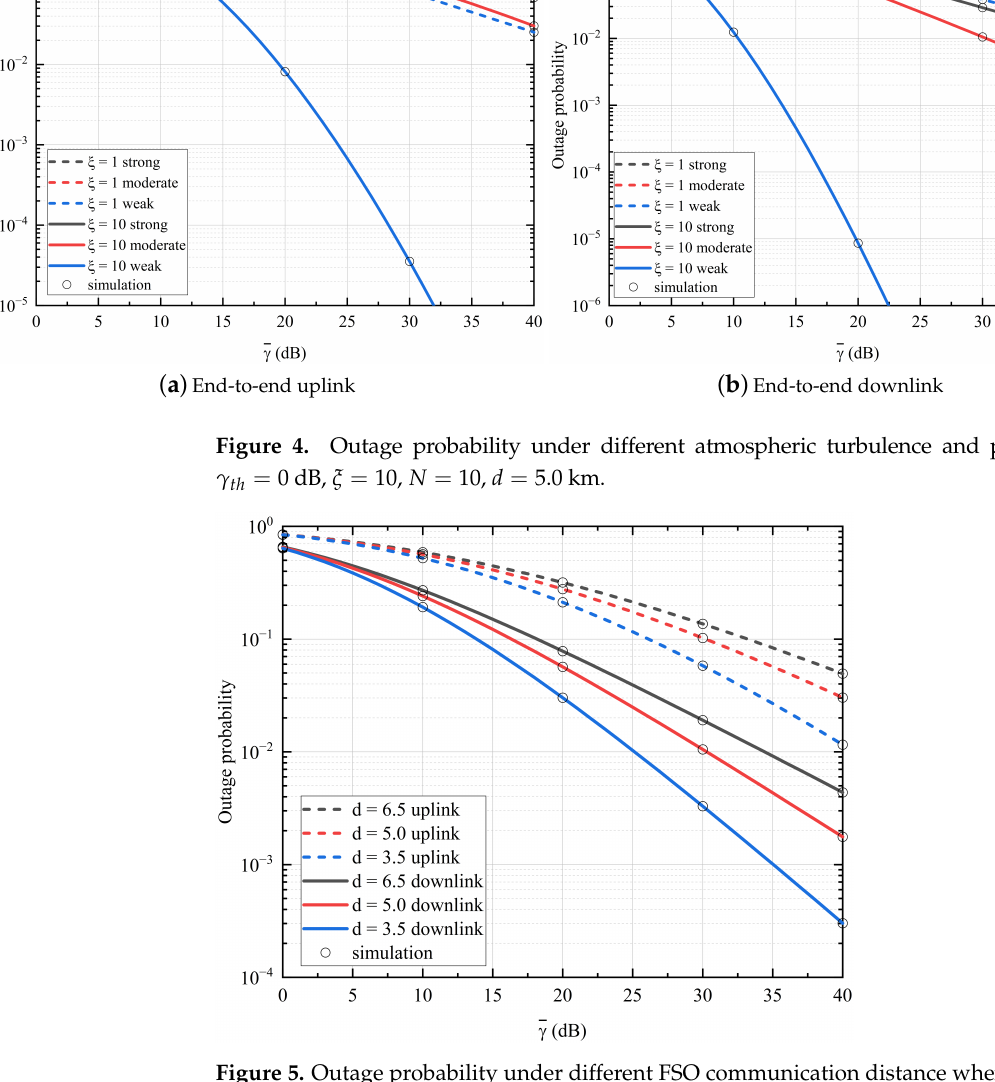
Figure 5. Outage probability under different FSO communication distance when γ th = 0 dB, ξ = 10, N =